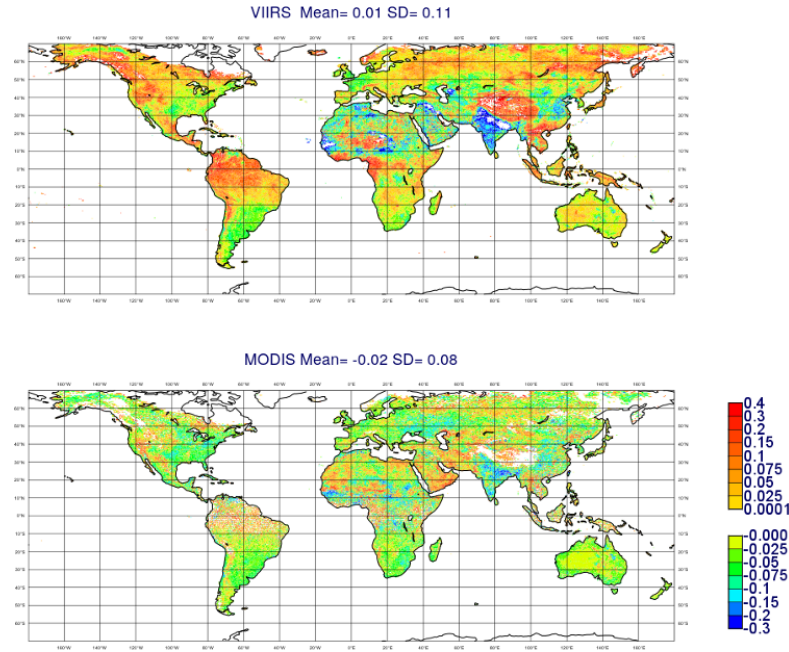
Figure D6. Global maps of mean first-guess departure from Terra and Aqua/MODIS as well as NOAA20 and SNPP/VIIRS for the MAM period over land.